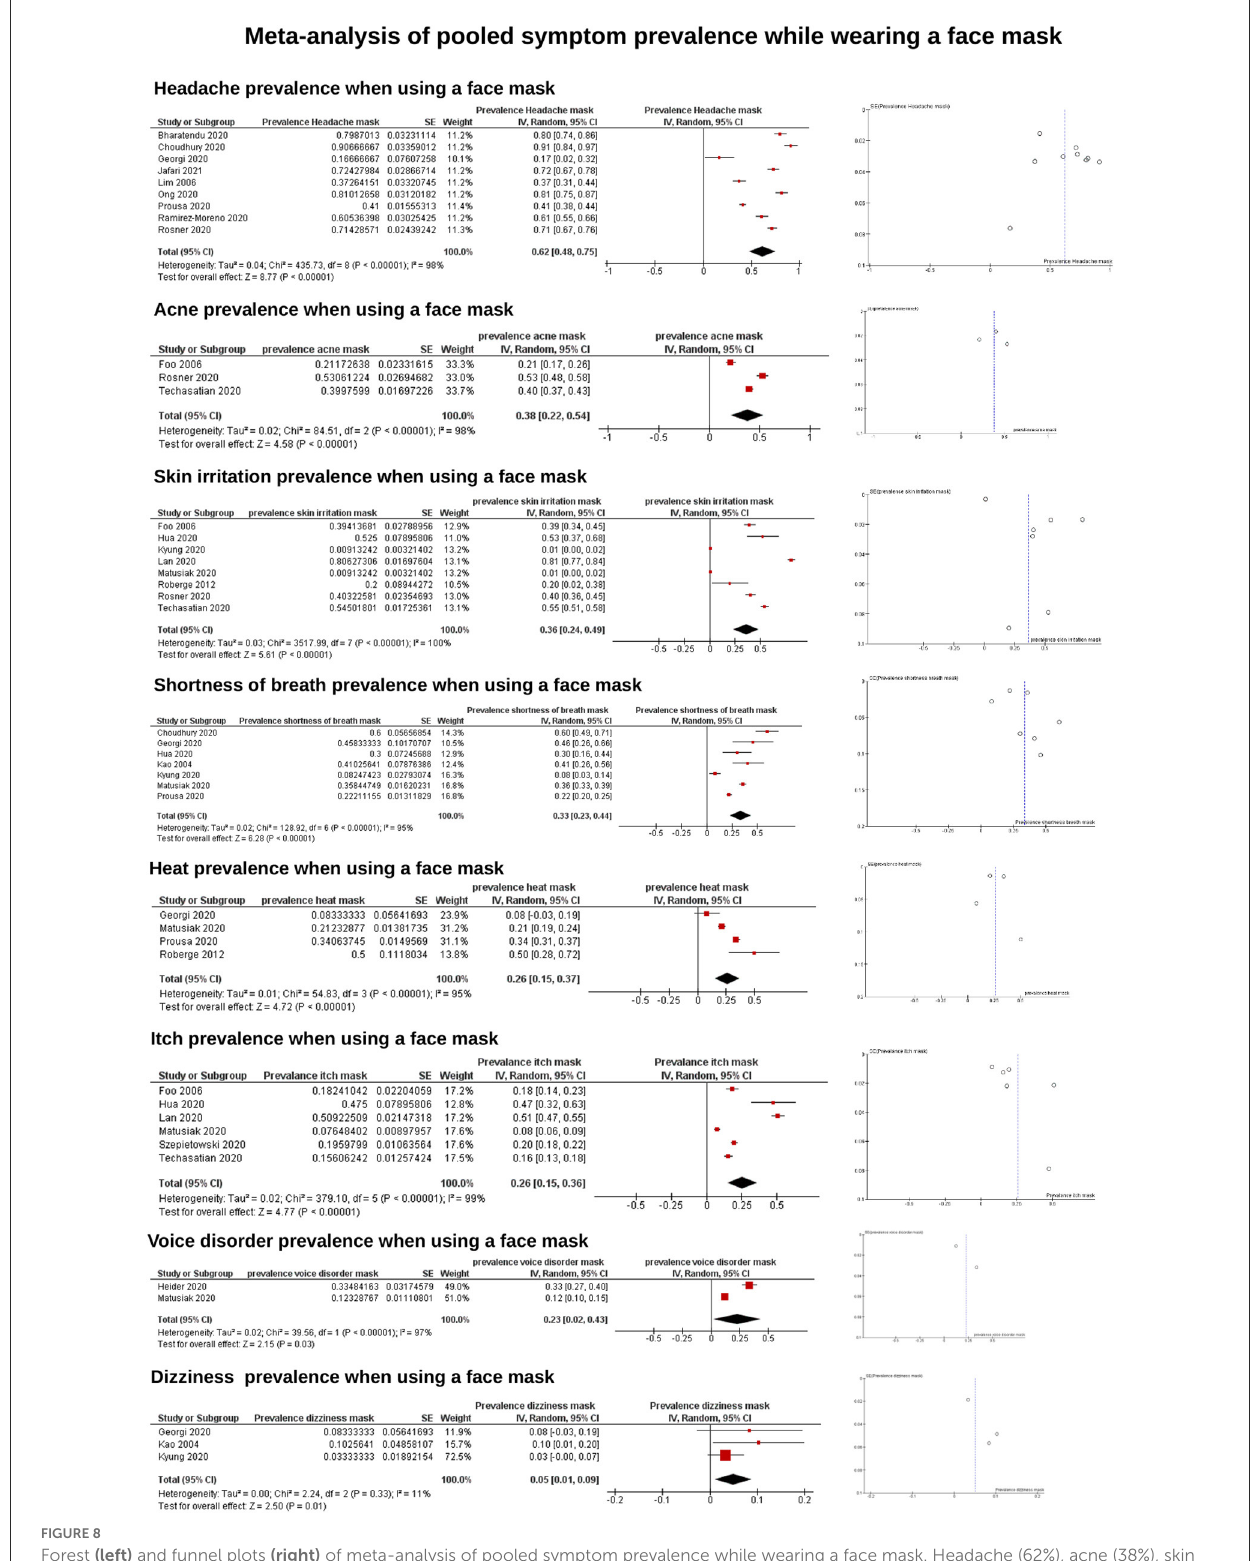
FIGURE8 Forest (left) and funnel plots (right) of meta-analysis of pooled symptom prevalence while wearing a face mask. Headache (62%), acne (38%), skin irritation (36%), shortness of breath (33%), heat (26%), itch (26%), voice disorder (23%), and dizziness (5%) while wearing a mask are significant in the evaluated population ( n =